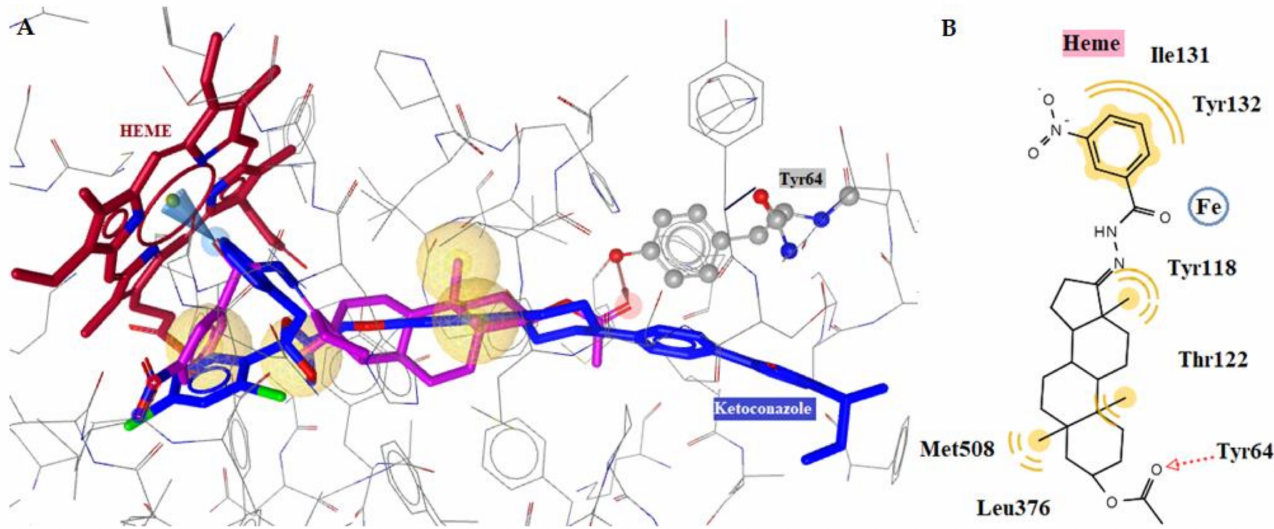
Figure 5. ( A ) Superposition of compound 8 (magenta) and ketoconazole (blue) in lanosterol 14 α - demethylase of C . albicans (CYP51 ca ). ( B ) Docked conformation of the most active compound 8 in lanosterol 14 α -demethylase of C . albicans (CYP51 ca ). Red dotted arrows indicate H-bond, blue arrows aromatic interactions and yellow spheres hydrophobic